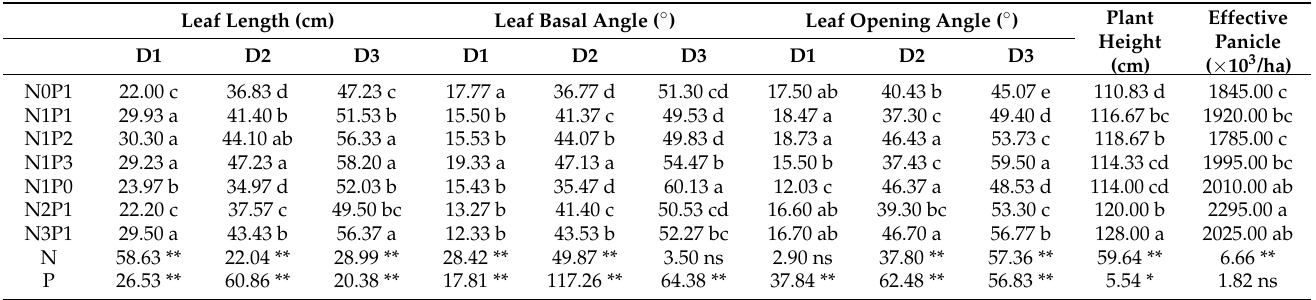
Table 1. Effects of nitrogen and N regulation on rice plant morphology. Leaf Length (cm) Leaf Basal Angle ( ◦ ) Leaf Opening Angle ( ◦